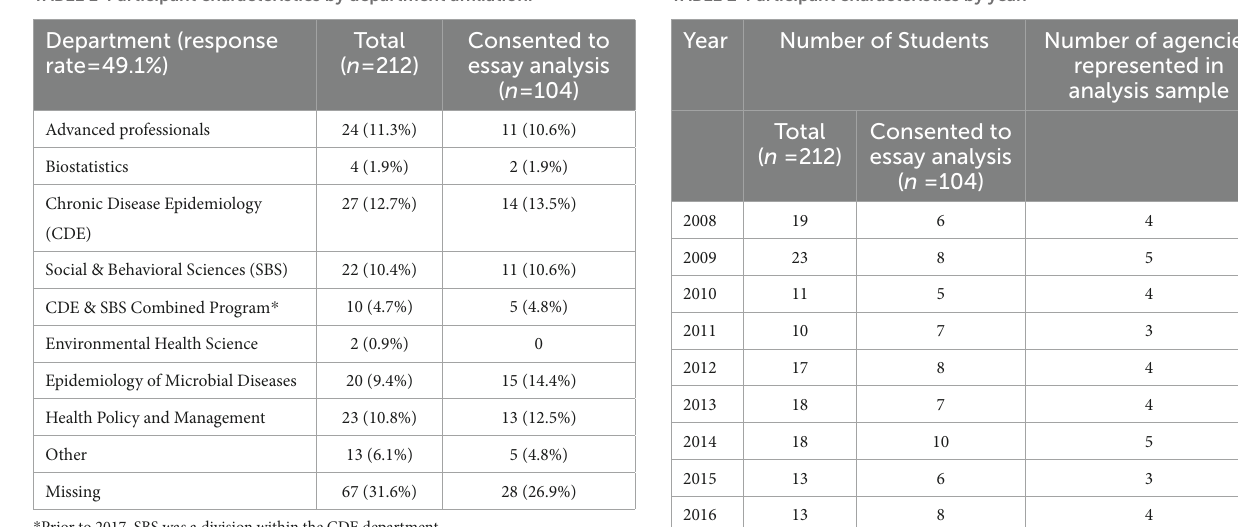
TABLE 2 Participant characteristics by year. TABLE 1 Participant characteristics by department